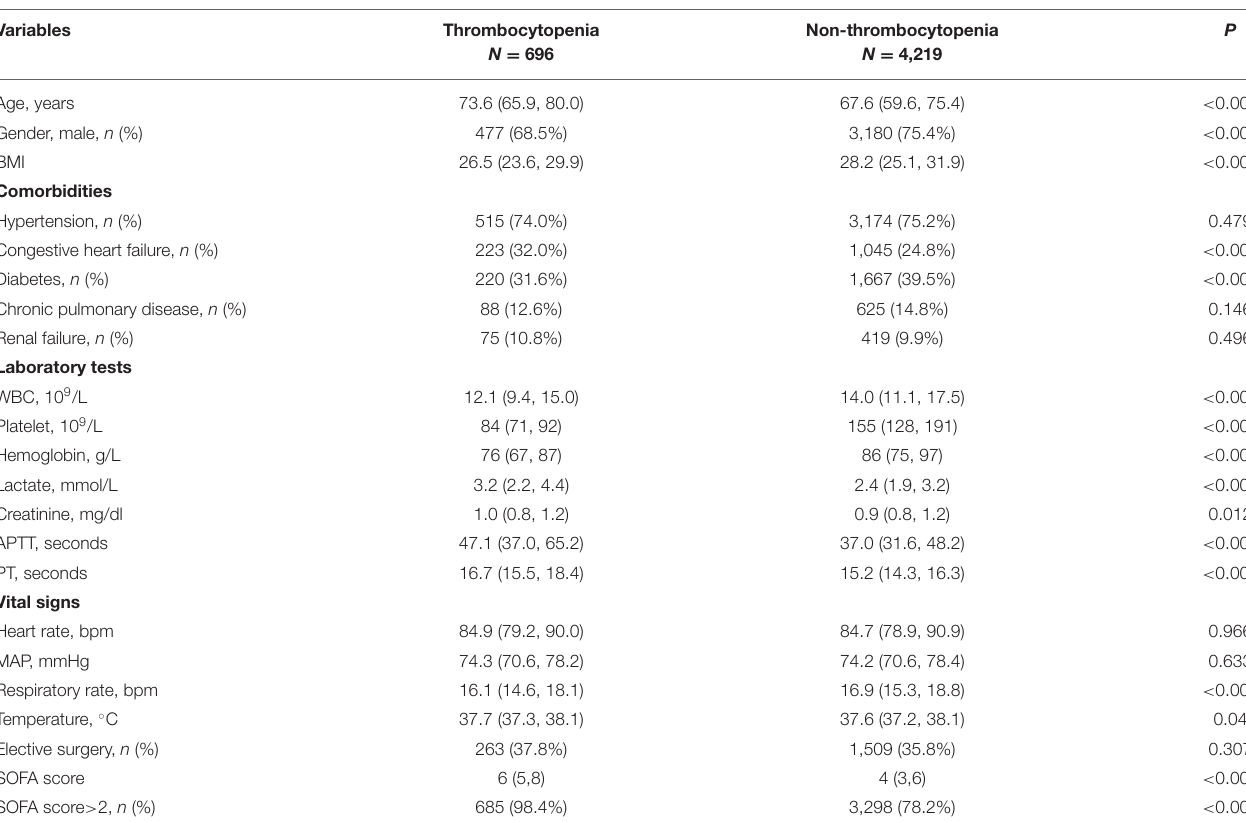
FIGURE 1 | The procedure of data selection and exclusion. TABLE 1 | Baseline and clinical characteristics of the study